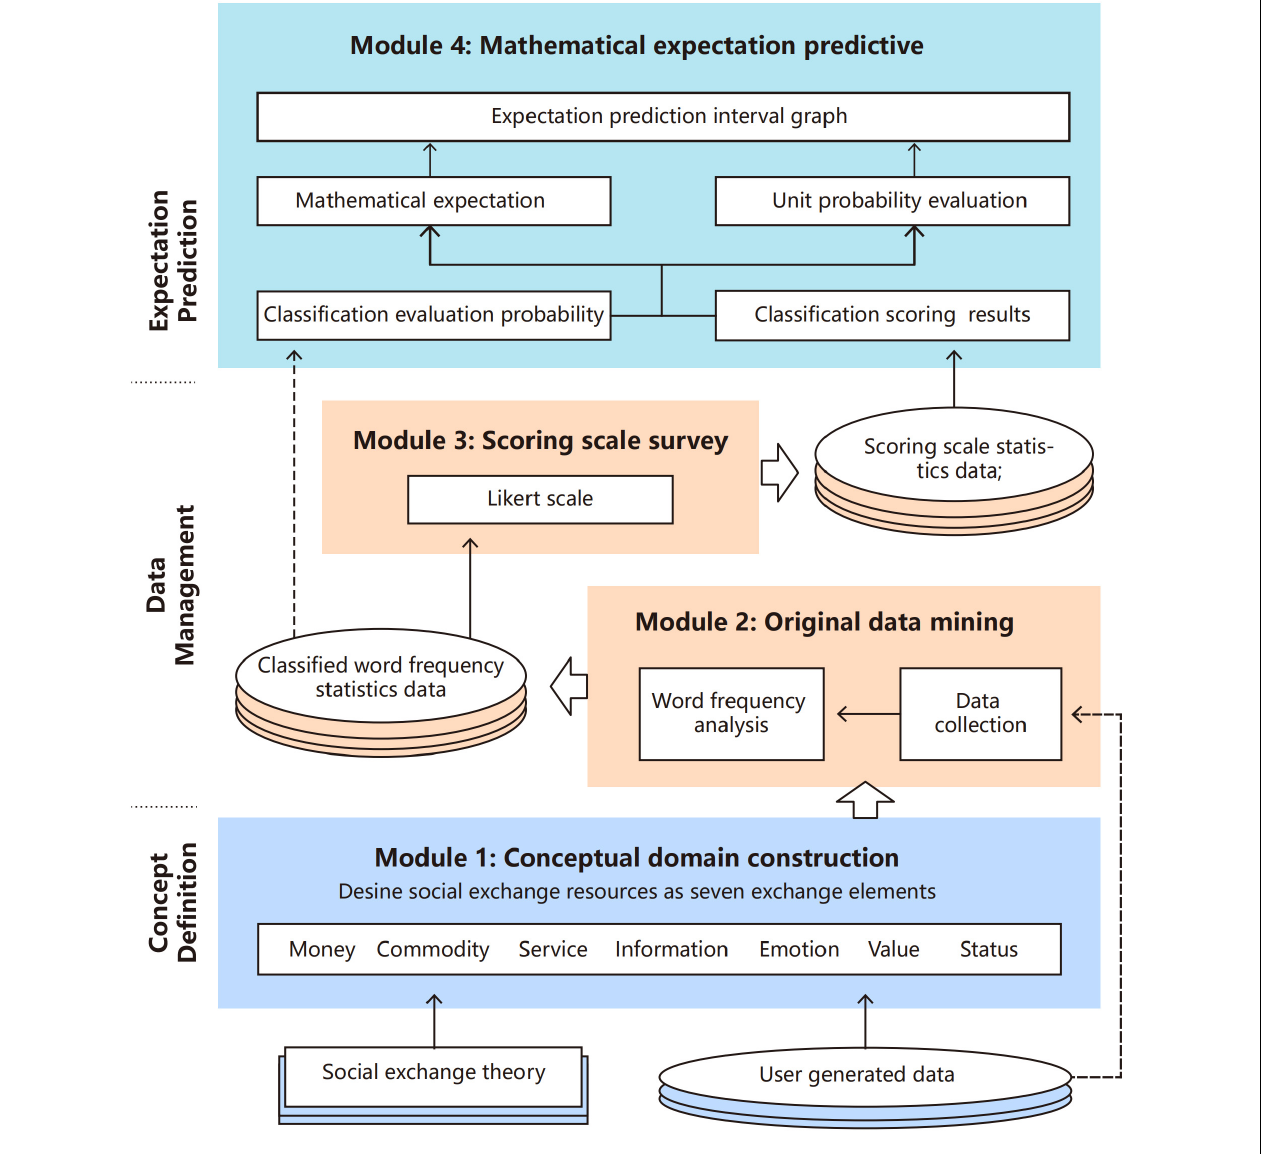
FIGURE 3 | Data-driven expectation prediction